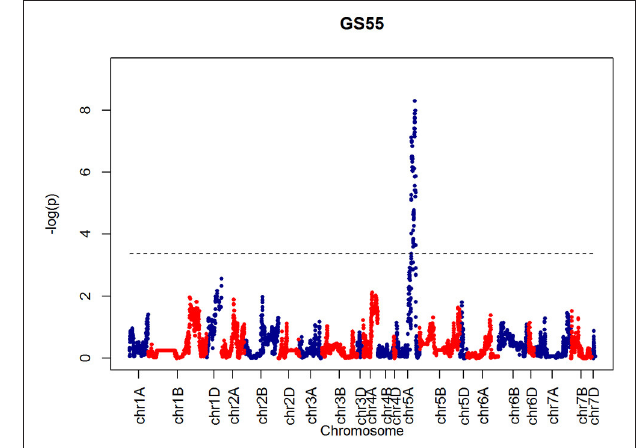
FIGURE 7 | QTLs markers for the trait GS39. Dashed lines indicate threshold (FDR < 0.05, logP4).